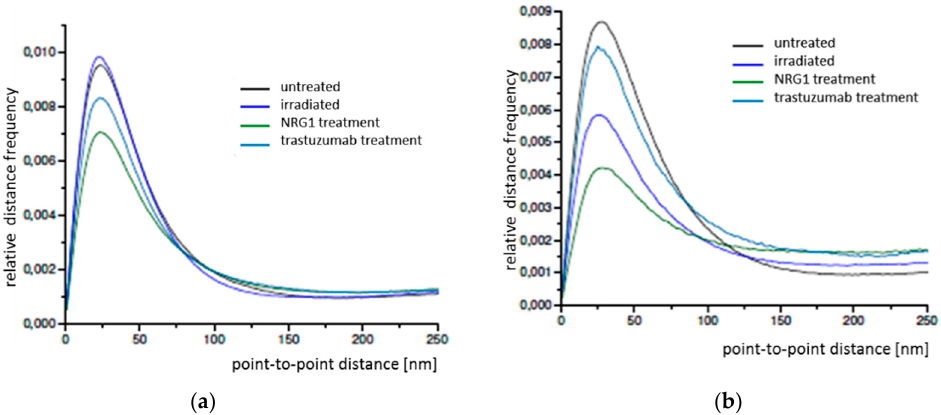
Figure 5. Relative distance frequency histograms of the next neighbor distances of fluorescently labelled Cx43 molecules in HIMAECs for the different treatment scenarios. The distances forming the peak correlate to connexons. ( a ) peripheral regions ( b ) perinuclear regions. In all cases the relative distance frequency histograms showed a peak at about 24 nm for the peripheral regions and about 28 nm for the perinuclear regions. In perinuclear region, for all cases